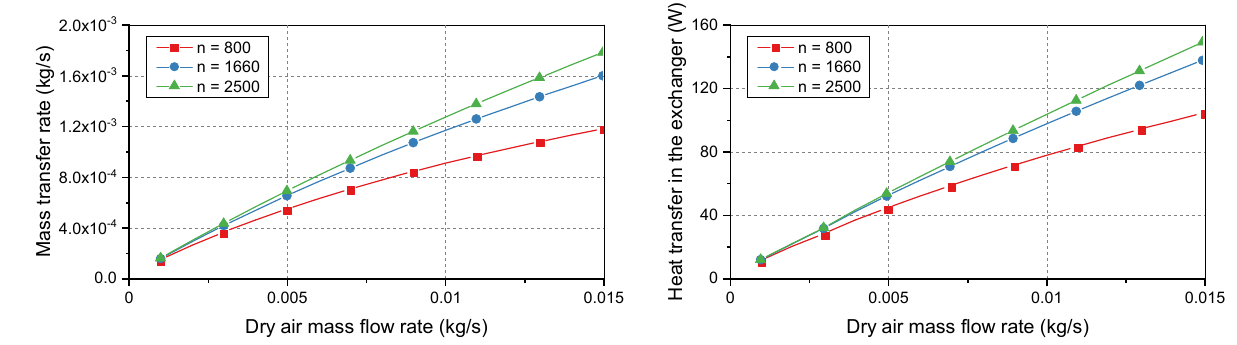
Figure 7. Effects of number of membranes on the humidifier performance.